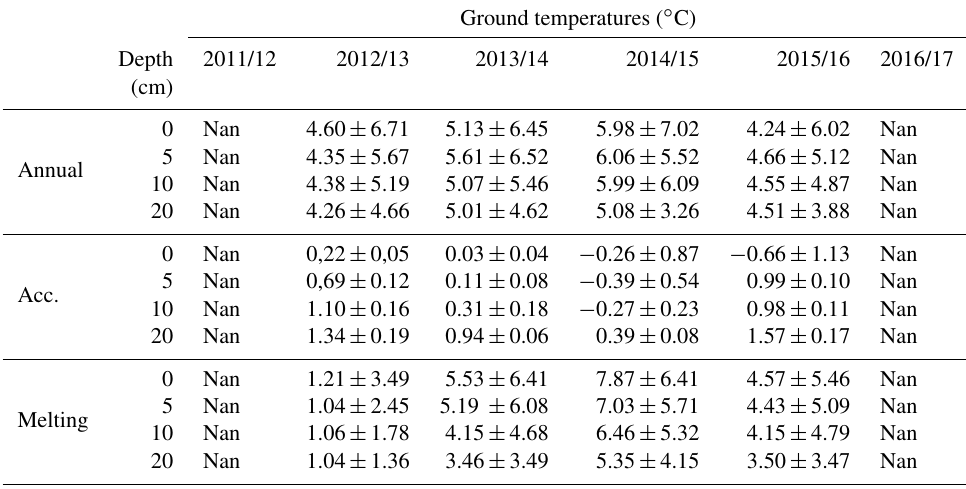
Table 4. Mean and standard deviation ground temperature for different depths for the five snow seasons for the annual, accumulation and melt